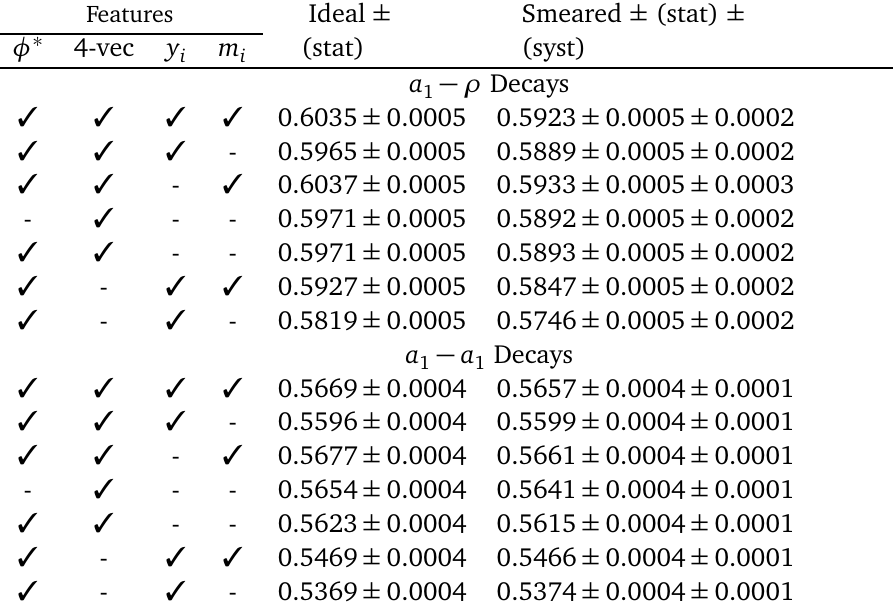
Table 2: Area Under the Curve is shown for the Neural Networks (NN) studied to separate scalar and pseudo-scalar hypotheses. Inputs with a (cid:51) are used. Results in column “Ideal" - from NNs trained / used with particle-level simulation, in column “Smeared" - from NNs trained / used with smearing. NN trained on smeared samples when used on exact samples give similar results as “Ideal" what in this case mean no detector smearing. Result taken from Ref. [ 22 ] . Reference frame as for Table